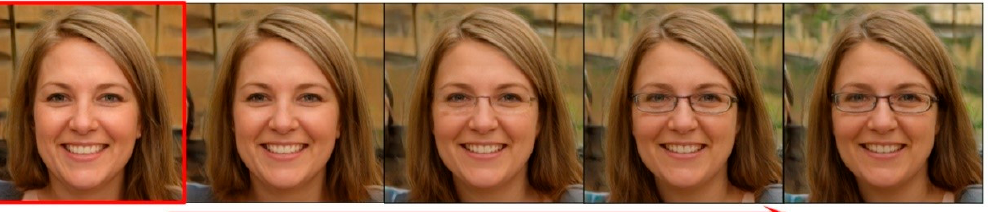
Figure 9. The result of editing the semantic attribute of glasses with local contrast regularization.